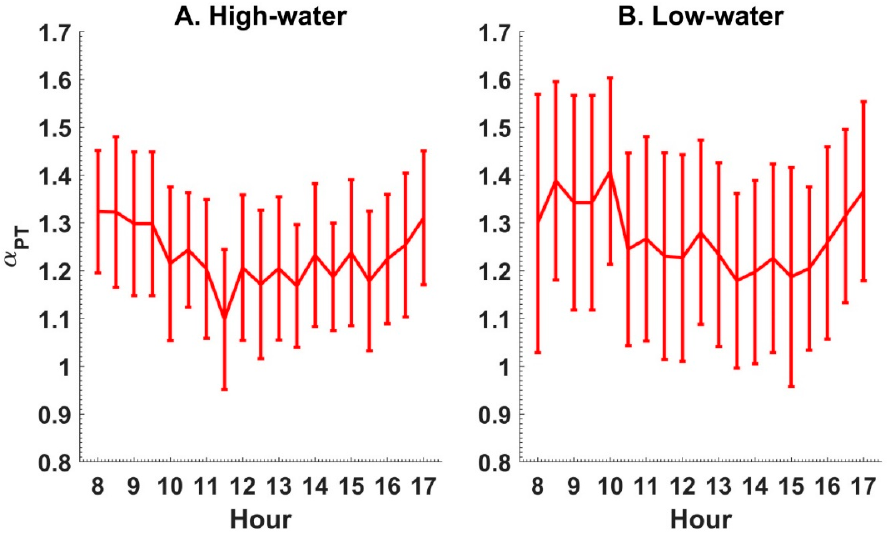
Figure 7. Diurnal variations in α during the high ‐ water ( A ) and low ‐ water ( B ) periods in 2015. The length of the bar in each subfigure represents the value of the standard deviation of the variable.